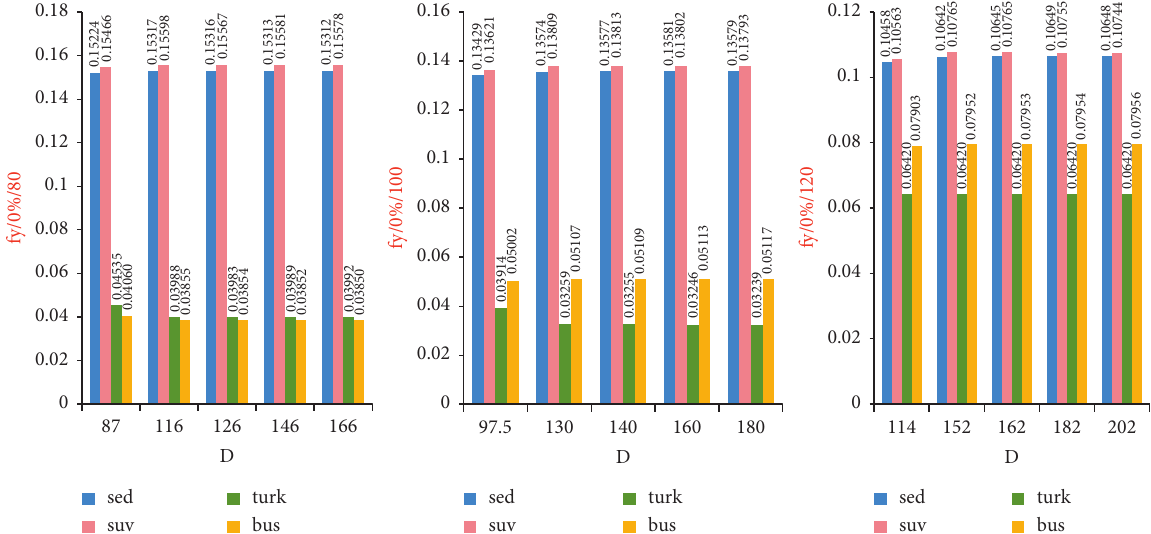
Figure 5: Changes in the lateral friction coefficient with direct distance change in straight scenario and speeds of 80, 100, and 120